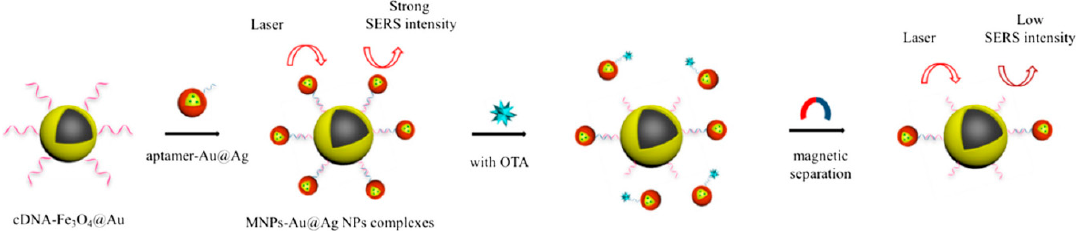
Figure 9. Schematic of the detection principle of the SERS-based aptasensor for ochratoxin A (OTA) detection. (Reprinted with permission from Springer, 2018 [73]).